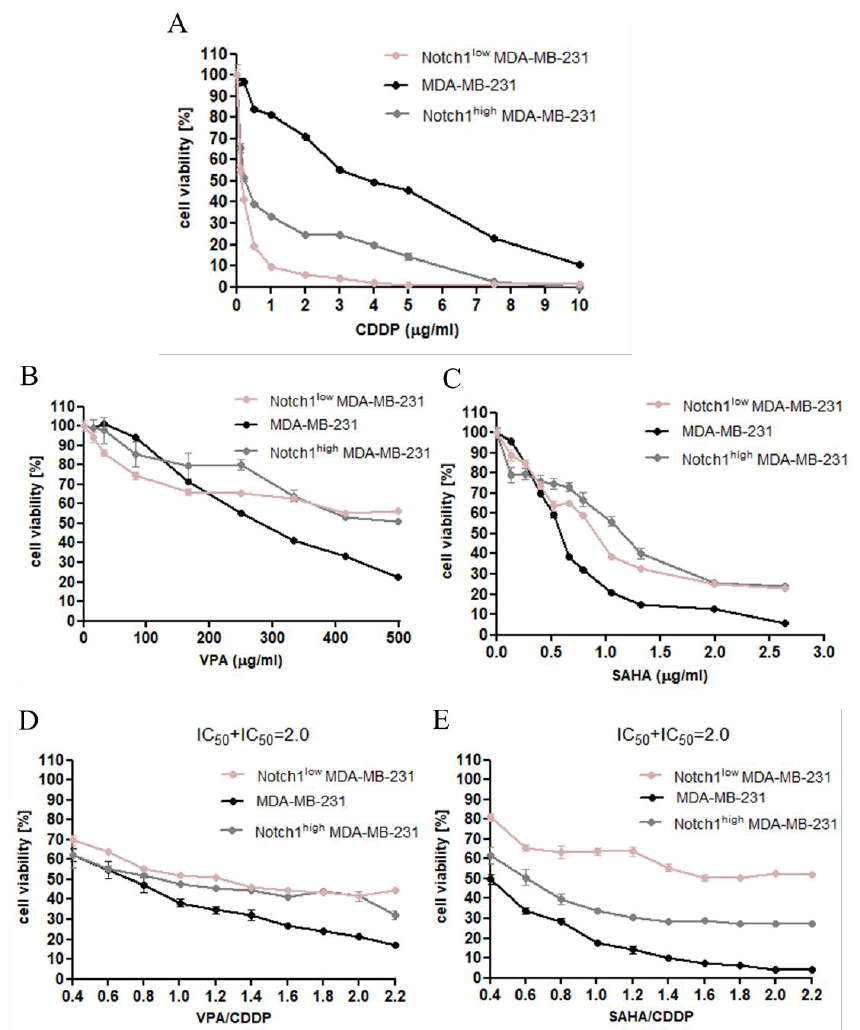
Figure 4. The anti-proliferative effects of CDDP and HDIs in MDA-MB-231 breast cancer cells. ( A ) The anti-proliferative effect of CDDP in MDA-MB-231 [28], Notch1 low MDA-MB-231, and Notch1 high MDA-MB-231 breast cancer cells; ( B ) the anti-proliferative effect of VPA in MDA-MB-231 [28], Notch1 low MDA-MB-231, and Notch1 high MDA-MB-231 breast cancer cells; ( C ) the anti-proliferative effect of SAHA in MDA-MB-231 [28], Notch1 low MDA-MB-231, Notch1 high MDA-MB-231 breast cancer cells; ( D ) the anti-proliferative effect of combined treatment of VPA and CDDP in MDA-MB-231 [28], Notch1 low MDA-MB-231, and Notch1 high MDA-MB-231 breast cancer cells; ( E ) the anti-proliferative effect of combined treatment of SAHA and CDDP in MDA-MB-231 [28], Notch1 low MDA-MB-231, and Notch1 high MDA-MB-231 breast cancer cells. Transfected and native MDA-MB-231 cells were exposed to concomitant HDIs and CDDP treatment using different ratios of the IC 50 (2.0 = IC 50 + IC 50 ). The cell viability was measured by the MTT assay. The results from three independent experiments ( n = 18) are presented as the mean ± standard error of the mean (±S.E.M). Table 1. IC 50 values (µg/mL) for CDDP and HDIs (SAHA and VPA) in transfected and native [28] MDA-MB-231 breast cancer cells.